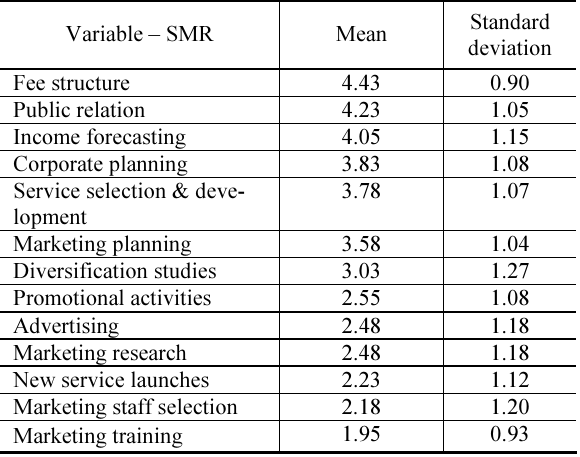
Table 4. Ranking of specific marketing responsibility